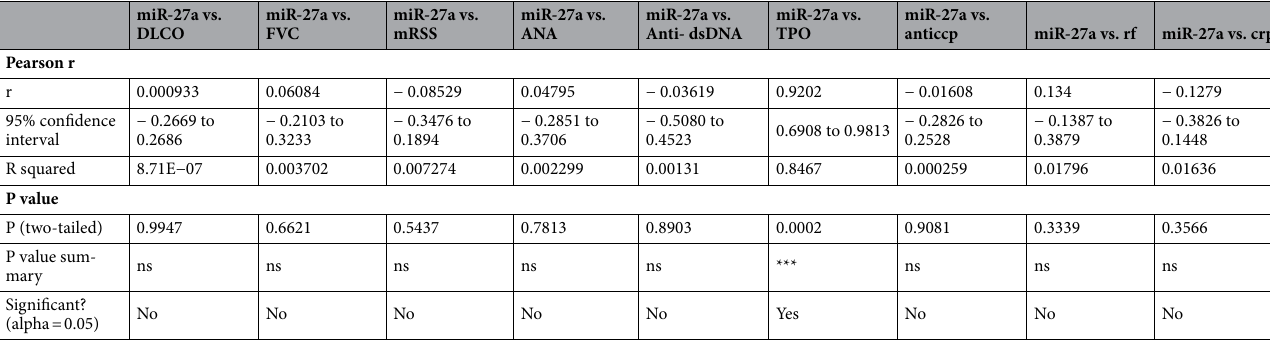
Table 2. Correlation statistics of miR-27a with disease symptoms and